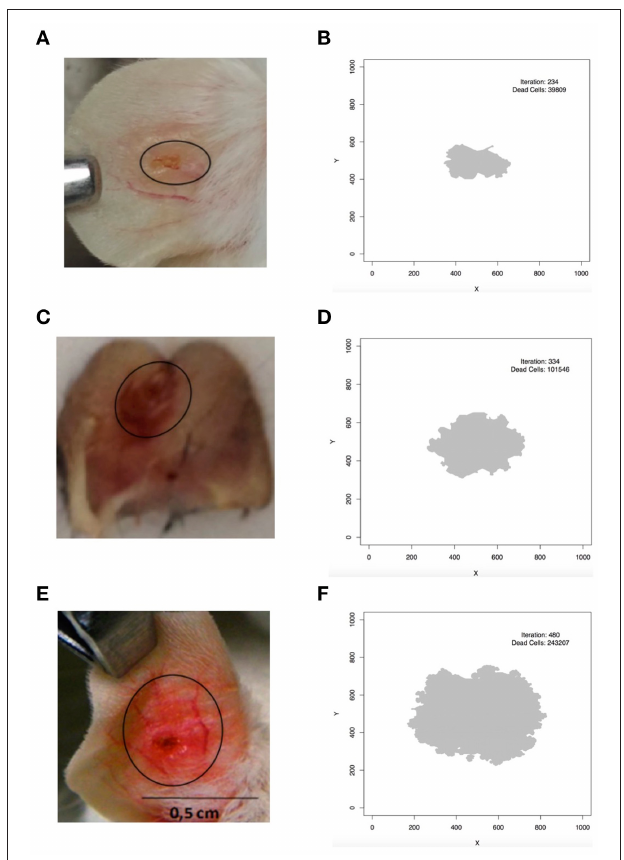
FIGURE 7 | Comparison between simulated and real lesion patterns. (A,B) L. braziliensis . (C,D) L. major . (E,F) L. amazonensis . (A) is courtesy of Priscila Guerra (FIOCRUZ, Brazil); (C) is from Maioli, TU unpublished data; (E) is from Araujo et al. (2014), reproduced in accordance with the policy of the journal. In (B,D,F) iteration is the step in which the screen shot of the lesion was taken and dead cells is the number of lattice-points that contain dead epithelial